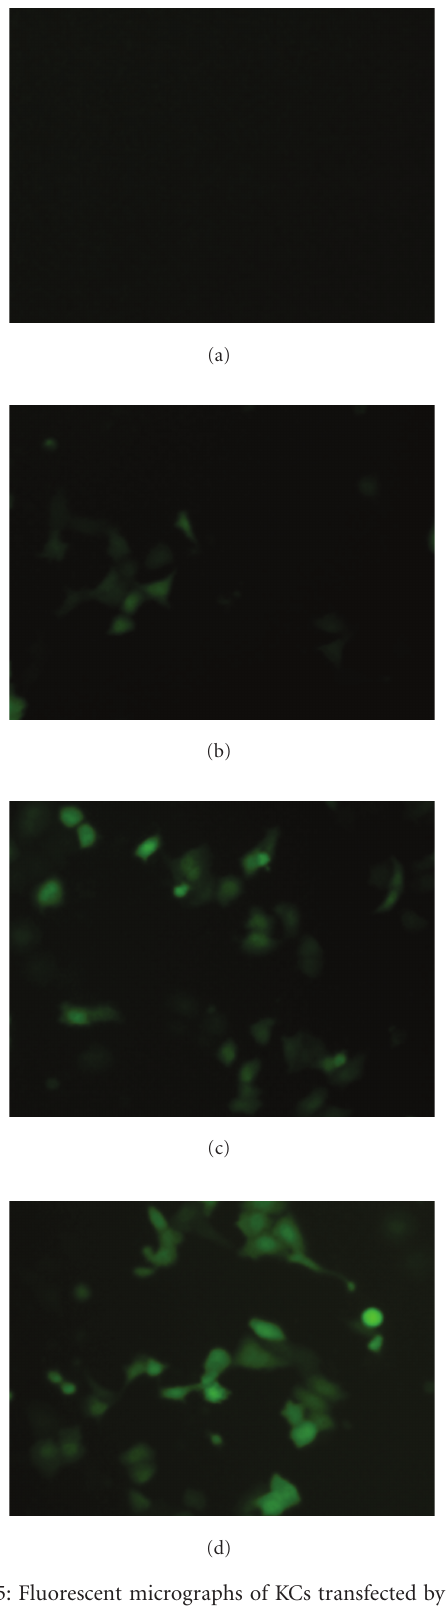
Figure 5: Fluorescent micrographs of KCs transfected by plasmid EGFP with DNA-NPs (c) and MAN-DNA-NPs (d). The KCs trans- fected by naked DNA (a), and Lipofectamine-DNA (b) was used as control.